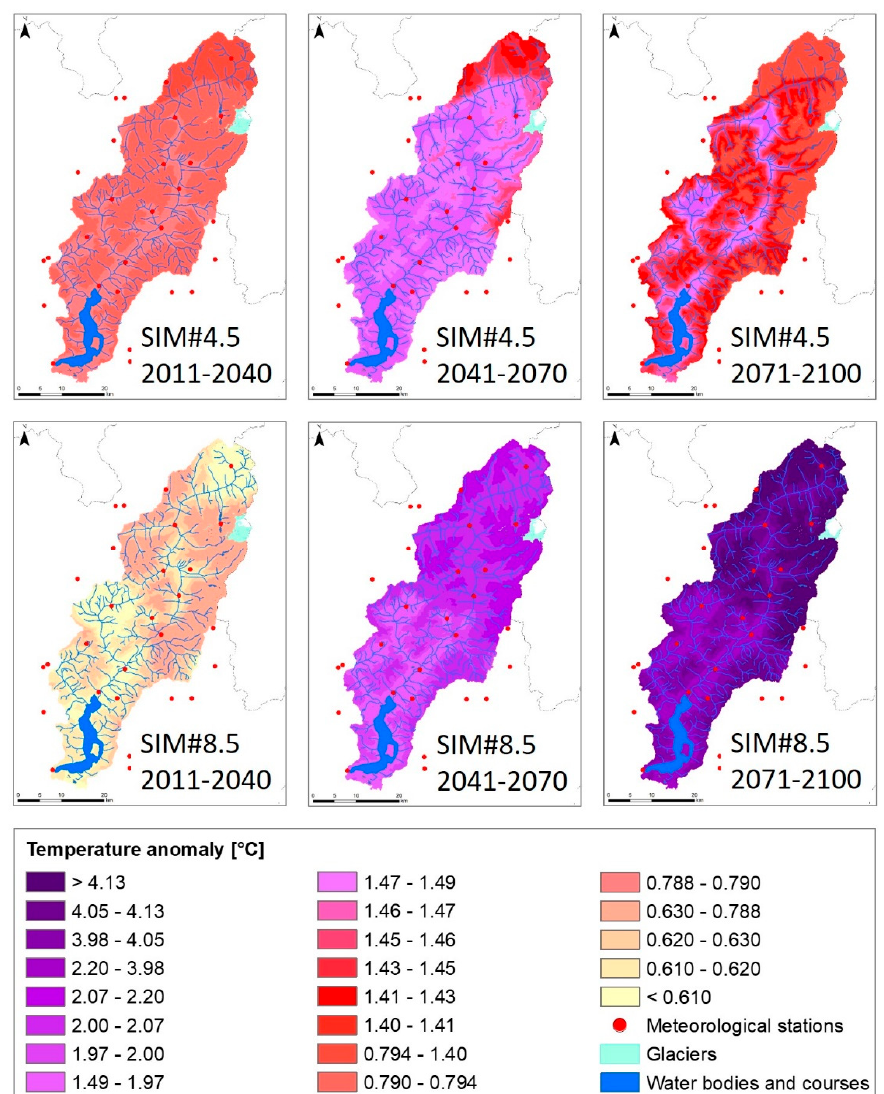
Figure 6. Mean temperature anomalies compared with the reference period (1981–2010): simulated with SIM#4.5 (first row) and SIM#8.5 (second row) at 2011–2040 (first column), 2041–2070 (second column), and 2071–2100 (third column).